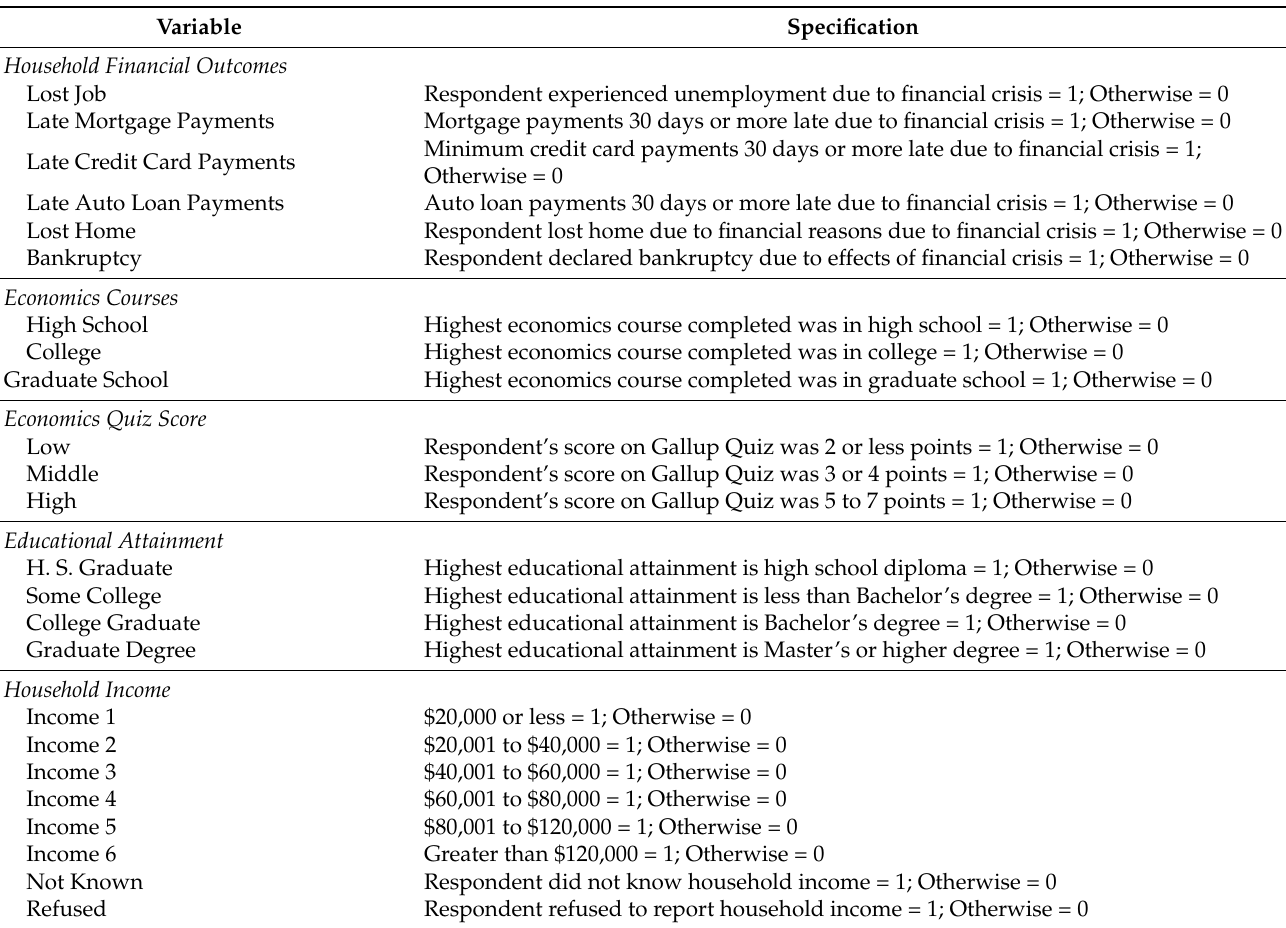
Table 5. Definition of